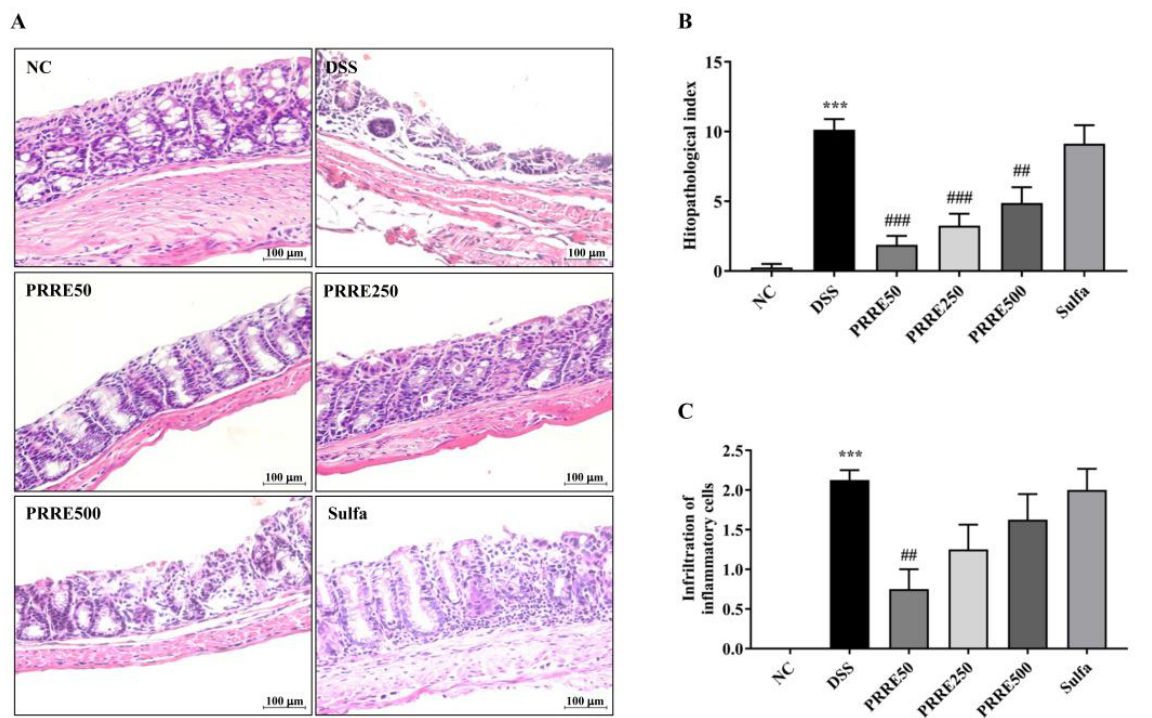
Figure 4. The effect of PRRE on histopathological damage in the colon induced by DSS. Histological images of distal colonic tissues stained with H&E after DSS induction for seven days ( × 200 magnifi- cation, scale bar = 100 µ m) ( A ), Histopathological index ( B ) and Infiltration of inflammatory cells ( C ). Data are expressed as mean ± SEM ( n = 8). *** p < 0.001 vs. NC group, ## p < 0.01 and ### p < 0.001 vs. DSS group. NC = normal control mice treated with the vehicle, DSS = mice treated with DSS alone, PRRE50 = DSS mice treated with PRRE at 50 mg/kg/day, PRRE250 = DSS mice treated with PRRE at 250 mg/kg/day, PRRE500 = DSS mice treated with PRRE at 500 mg/kg/day and sulfa = DSS mice treated with sulfasalazine at 50 mg/kg/day.